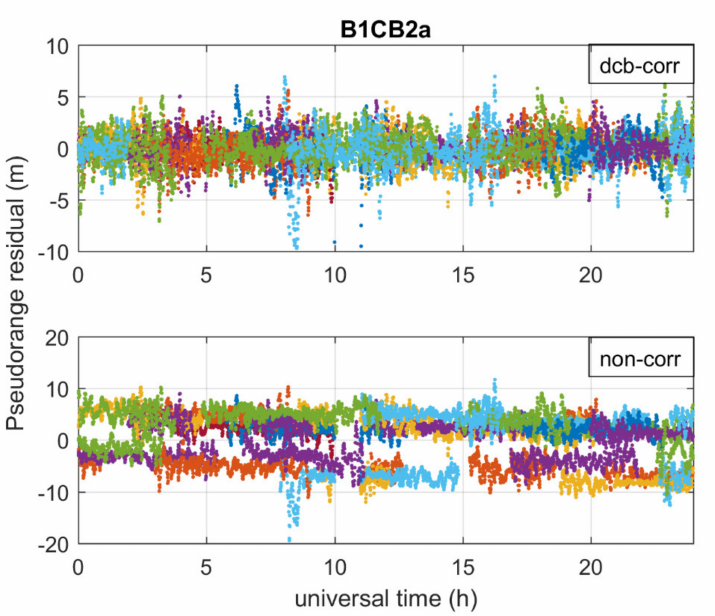
Figure 24. Pseudorange residual scatters of PPP with different schemes at BRCH